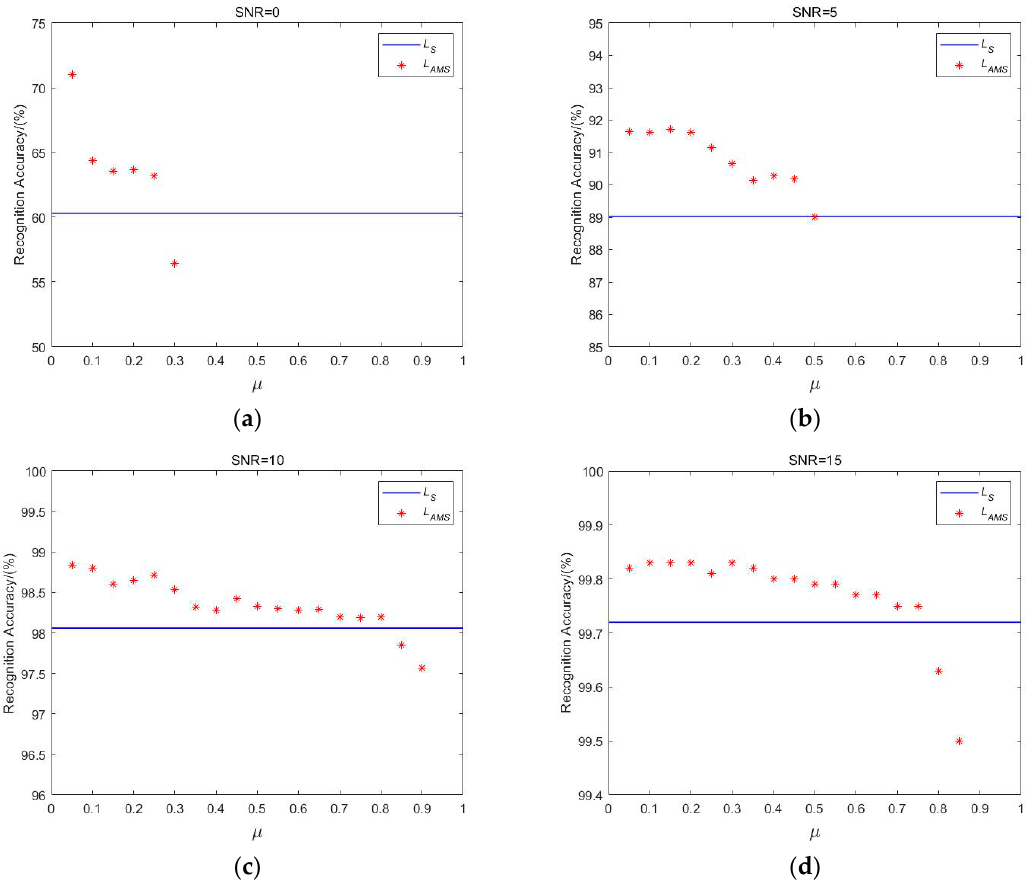
Figure 8. Recognition accuracy of model A with the dataset under different SNR conditions. ( a ) SNR = 0 dB; ( b ) SNR = 5 dB; ( c ) SNR = 10 dB; ( d ) SNR = 15 dB. The blue line suggests the recognition accuracy of model A using the loss function